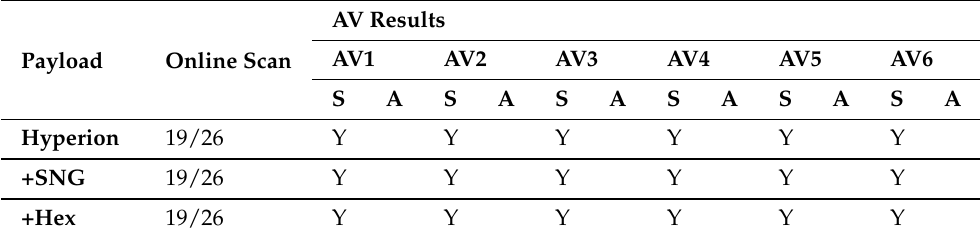
Table 1. Hyperion